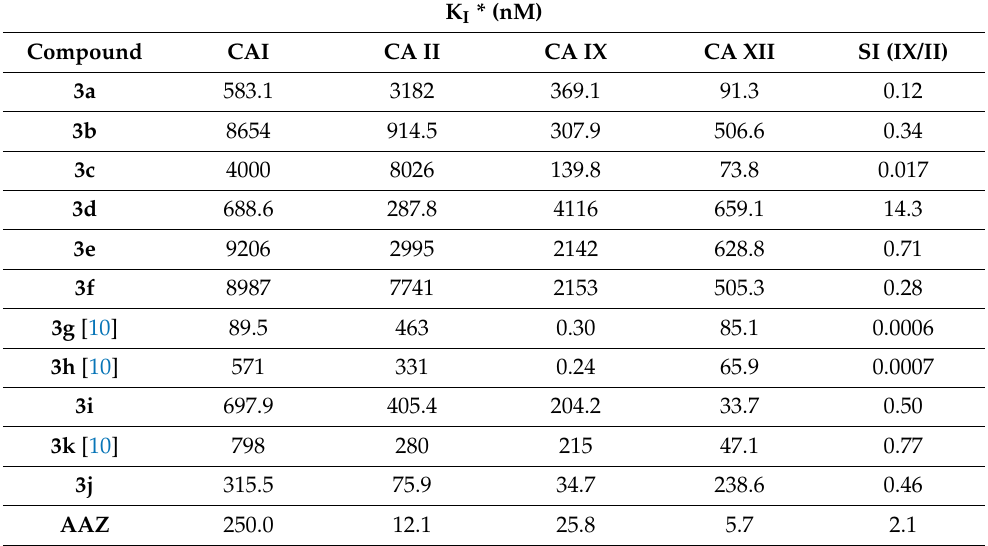
Table 1. Inhibition data of human CA isoforms I, II, IX, and XII with derivatives 3a – k and the standard sulfonamide inhibitor acetazolamide ( AAZ ) by the stopped-flow CO 2 hydrase assay [14]. K I *